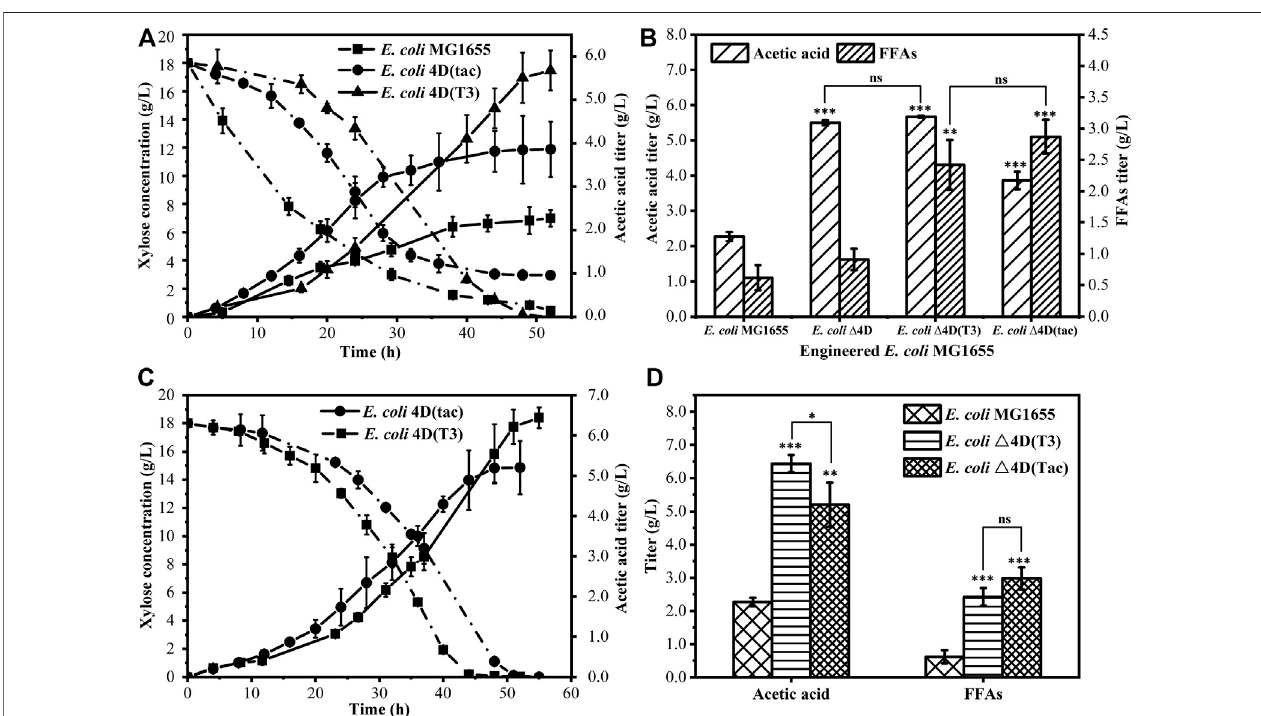
FIGURE 3 | Production of acetic acid and fatty acids by engineered E. coli in a bioreactor (A) Process diagram of E. coli MG1655, E. coli Δ 4D (T3), and E. coli Δ 4D (tac) using xylose to produce acetic acid in a bioreactor (B) acetic acid and FFAs titer obtained by fermentation of E. coli MG1655 and engineered E. coli , and the cultivationtimewas55 h (C) Processdiagramof E.coli Δ 4D(T3)and E.coli Δ 4D(tac)usingxylosetoproduceaceticacidinabioreactorafteroptimizationofthenitrogen source (D) Comparison of the titers of acetic acid and FFAs obtained by fermentation of E. coli MG1655 and engineered E. coli , and the cultivation time was 55 h. The error bars indicate the standard deviation of triplicate experiments. * p < 0.05; ** p < 0.01; *** p < 0.001; ns, no signi fi